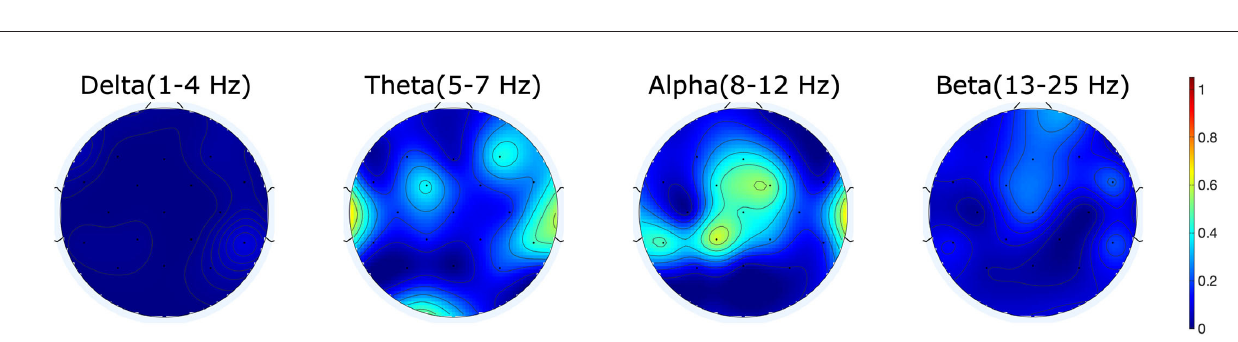
FIGURE 2 | R 2 -values showing the difference in power for the different frequency bands between correct and error trials show activity mainly in the alpha range for the measured